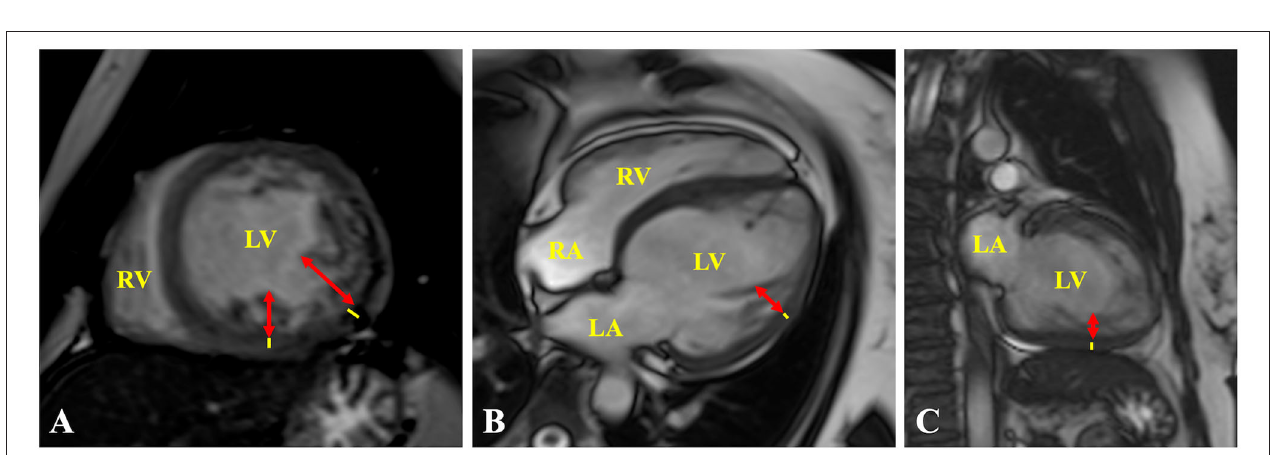
FIGURE 3 | Cardiac MRI. (A) Short axis, (B) 4-chamber, and (C) 2-chamber views showing representative measurements of the ratio of ticker non-compacted (redlines) to thin compacted (yellow lines) myocardium > 2.3 at end-diastole, in the (A) mid-inferolateral, (B) mid-anterolateral, and (A,C) mid-inferior segments. LA, left atrium; LV, left ventricle; RA, right atrium; RV, right